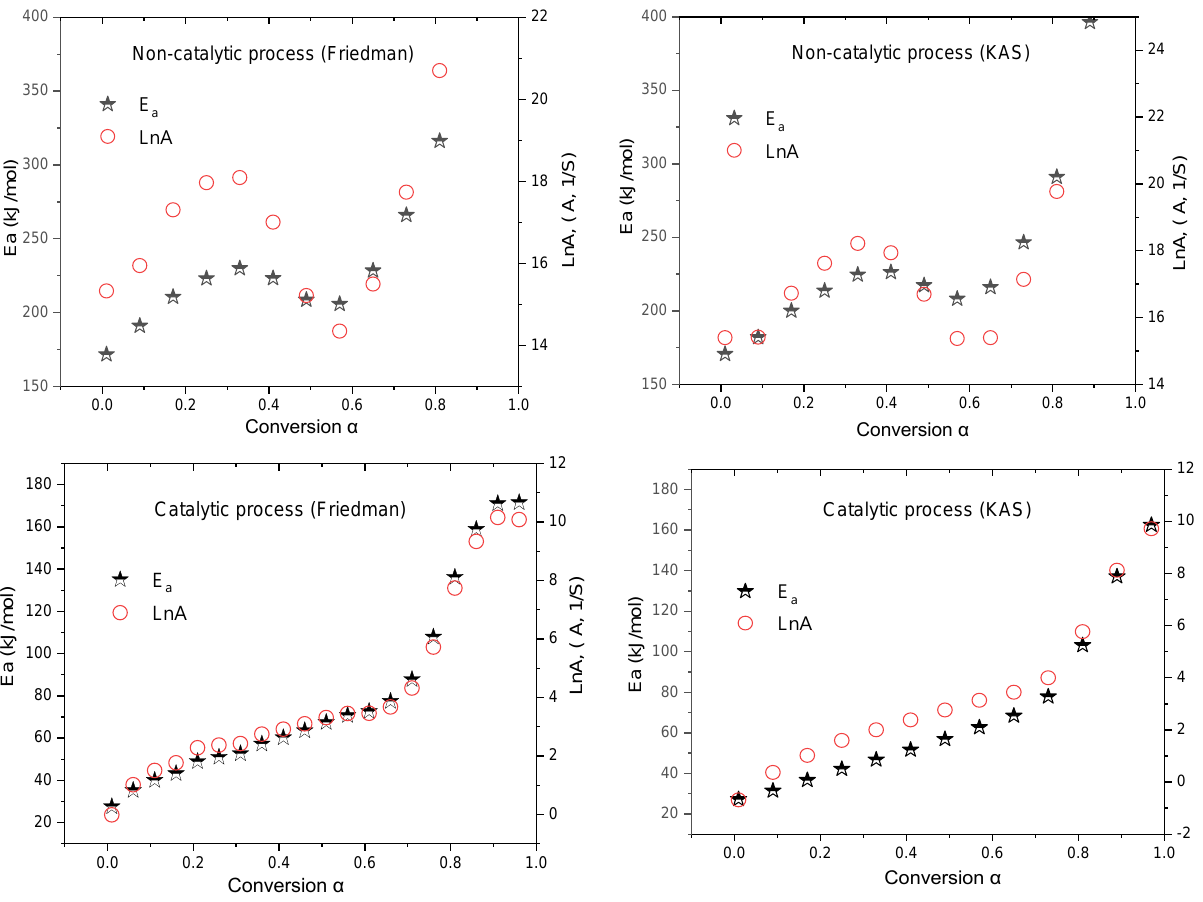
Figure 2. Pyrolysis activation energy and pre-exponential factors dependency on conversion degree in the presence and absence of catalyst obtained by KAS and Friedman. Table 3. Activation energies of catalytic and non-catalytic pyrolysis process based on KAS and Friedman methods.